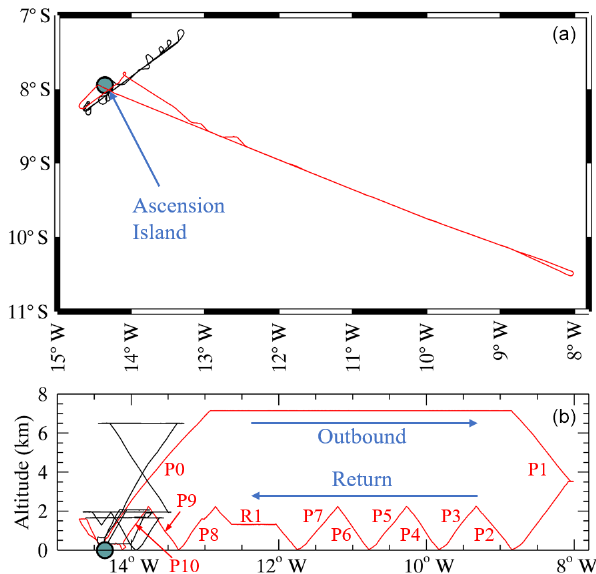
Figure 1. Flight track and altitude for flights C051 (black) and C052 (red). The locations of selected vertical profiles (P0 to P10) and run (R1) on flight C052 are indicated in panel (b)